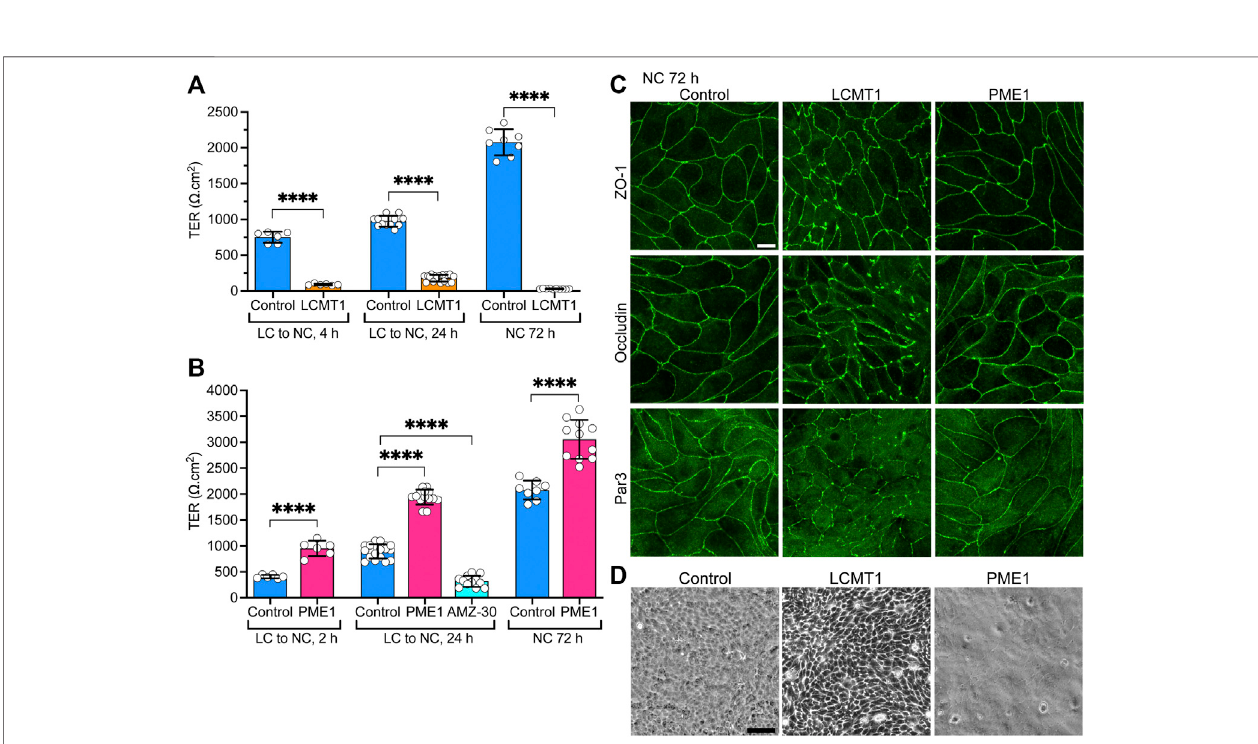
FIGURE 4 | Differential effects of LCMT1 and PME1 on TJ morphology and barrier function in MDCK cells. (A – B) TER values were measured in control MDCK (A – B) , MDCK-LCMT1 (A) and MDCK-PME1 (B) cellsat either 2,4or24 h after aCa 2+ switch,and 72 h after culture inNC medium.Asubset ofcontrolcellswastreated with 1 μ M AMZ-30 (AMZ-30). Values (mean ± SD from individual Transwells from separate experiments) were assessed using one-way ANOVA[F = 788, p < 0.0001 for (A) ;F=292.3, p < 0.0001for (B) ]with Š ídák ’ smultiplecomparisonstest;**** p < 0.0001. (C) ComparativedistributionofZO-1,occludinandPar3incontrolMDCK, MDCK-LCMT1, and MDCK-PME1 cells cultured for 72 h in NC medium. (D) Analysis of con fl uent control MDCK, MDCK-LCMT1, and MDCK-PME1 monolayers by phase-contrast microscopy (×10 objective). For (C – D) , representative images from three separate experiments are shown. Scale bars = 10 μ m.